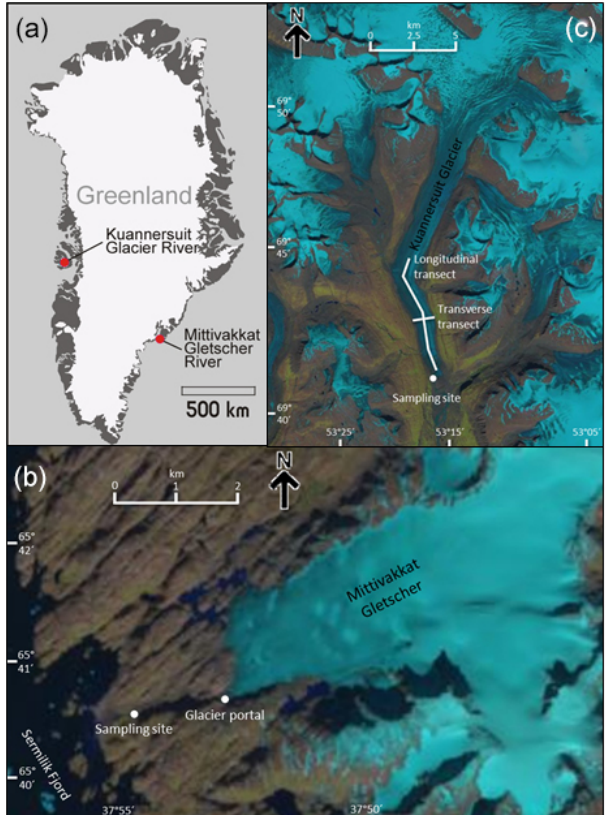
Figure 1. Location map (a) of the study areas at (b) the Mittivakkat Gletscher river, southeast Greenland (image from Landsat 8 OLI on 3 September 2013), and at (c) the Kuannersuit Glacier river, west Greenland (image from Landsat 8 OLI on 8 July